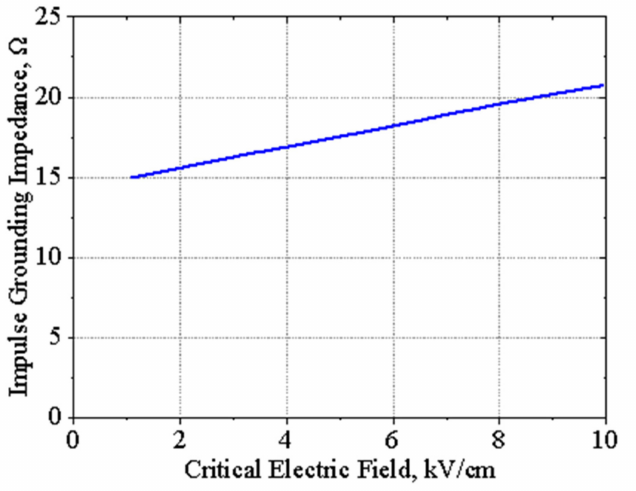
Figure 8. Influence of the critical electric field on the impulse grounding impedance of a vertical rod of 10 m, soil resistivity of 500 Ω m, current peak of 50 kA and waveform of 0.25/100 µ